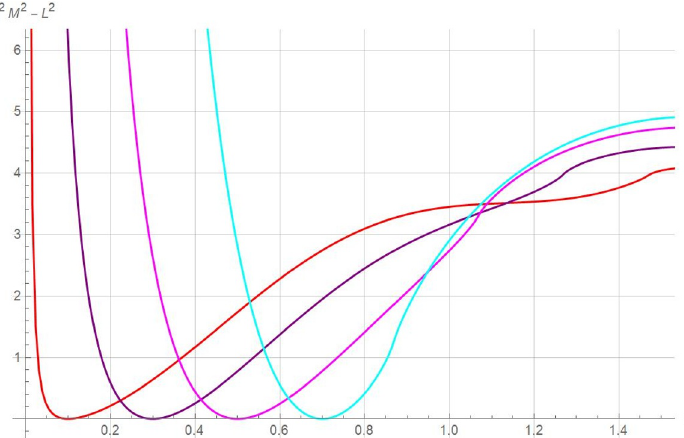
Figure 1 . We plot M 2 l 2 − L 2 . This quantity is seen to be positive everywhere and becomes zero at the point where the parametrization degenerates and we have a point particle moving at the speed of light. Smaller a gives a string with cusps on the inside and larger a gives cusps on the outside. The strange bumps occur when we go from outwards cusps to no cusps at all, namely when a > π/ 2 − b . Each graph corresponds to a value of b , starting with 0.1 in red, 0.3 in purple, 0.5 in magenta and 0.7 in cyan.